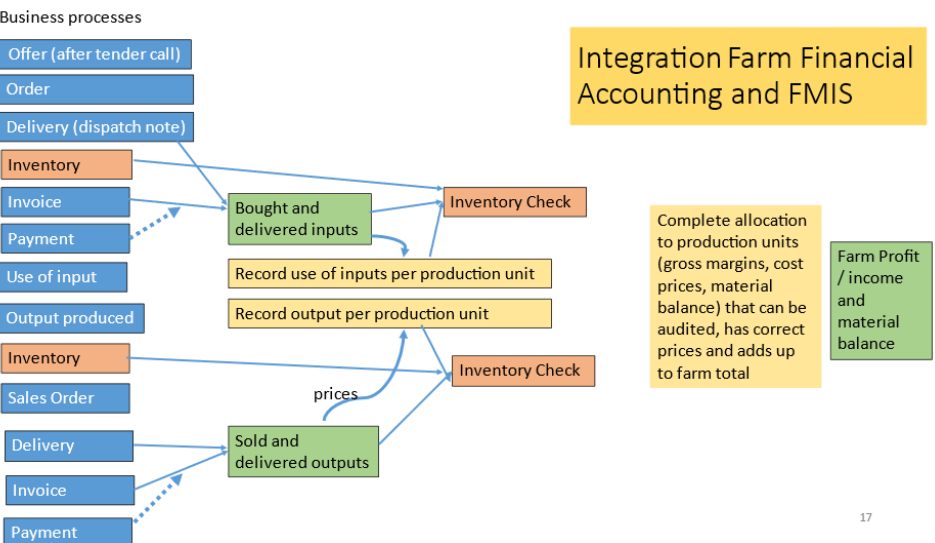
Figure 4. How Farm Financial Accounting and Farm Management Information Systems can